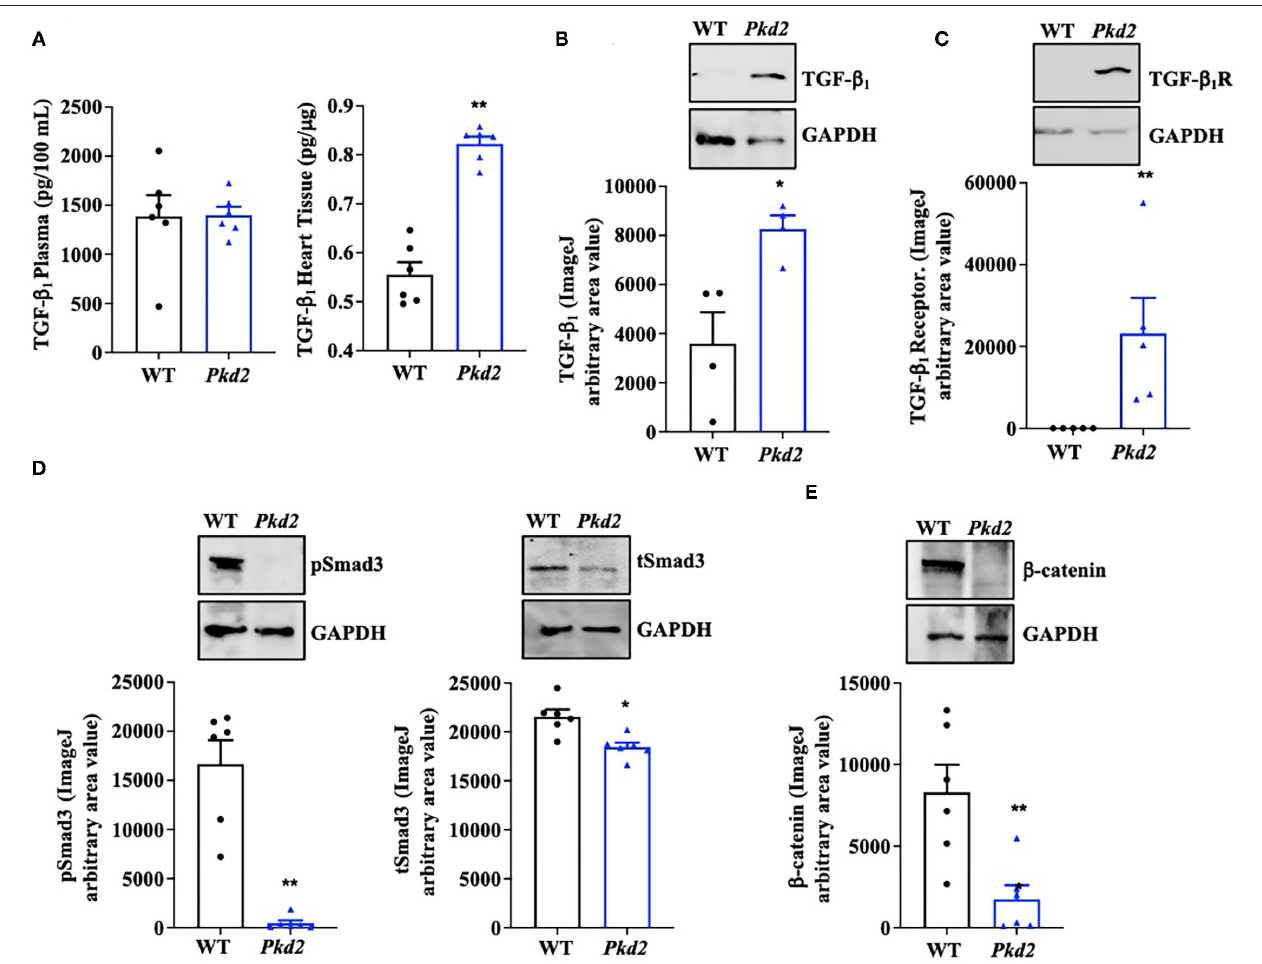
FIGURE 7 | The hearts from Pkd2 -KO mice demonstrate abnormal fibrotic pathways. (A) ELISA measurements of TGF- β 1 were done in circulating plasma (left panel) and heart tissues (right panel). (B,C) Western blot analyses of mouse tissues show significantly higher expressions of TGF- β 1 and TGF- β 1 receptors in Pkd2 -KO ( Pkd2 ) compared to WT mice. (D,E) Western blot analyses of mouse tissues show significantly higher expressions of tSMAD3, pSmad3, and β -catenin in WT compared to Pkd2 -KO mice. N = 4–6 mice for each WT and PKD age-matched 6 months old. * p < 0.05; ** p <